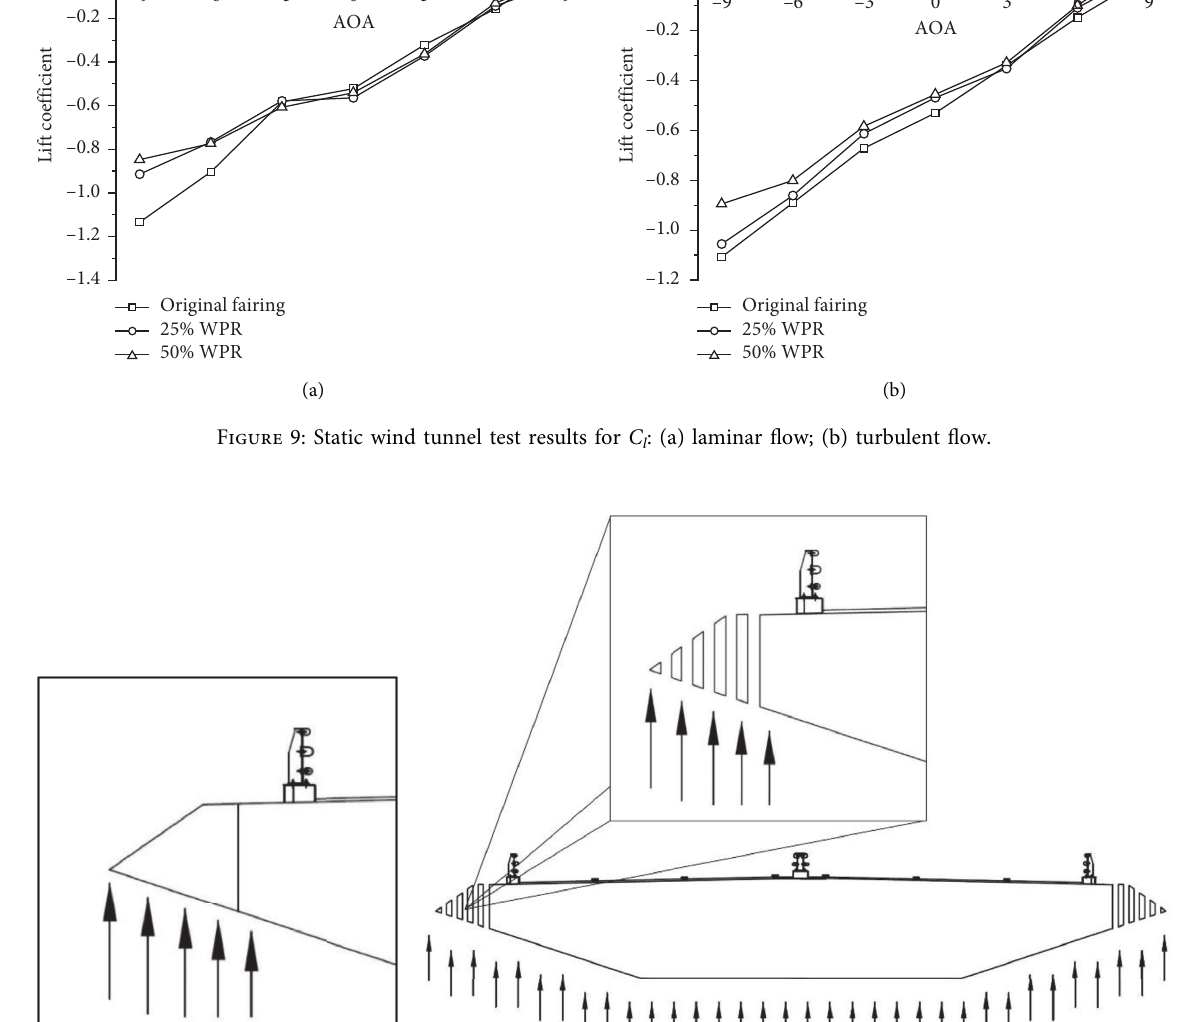
Figure 10: Schematic of the reduction of the lifting force resisting area by applying the proposed